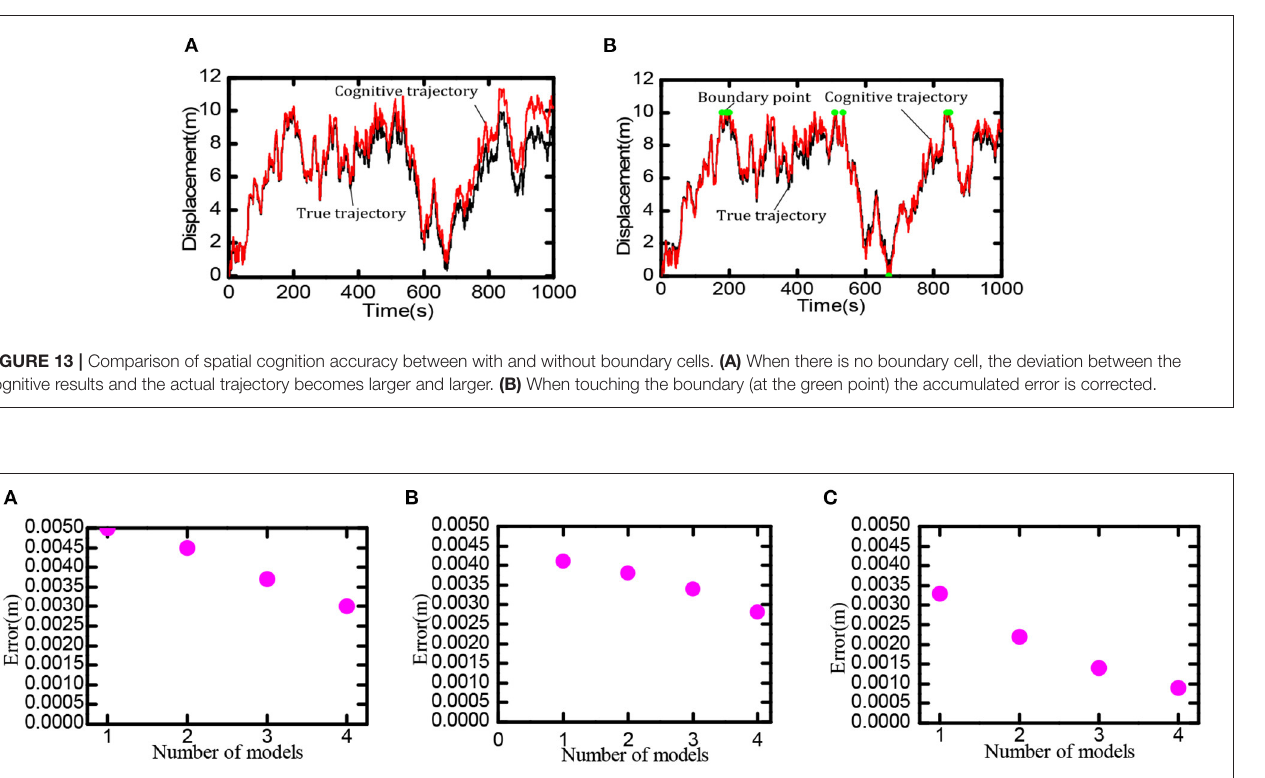
FIGURE 14 | Position decoding experiment for grid cells. Part labels (A–C) are the experimental data when the number of cells in the grid neural plate is 50 × 50, 100 × 100, and 200 × 200.